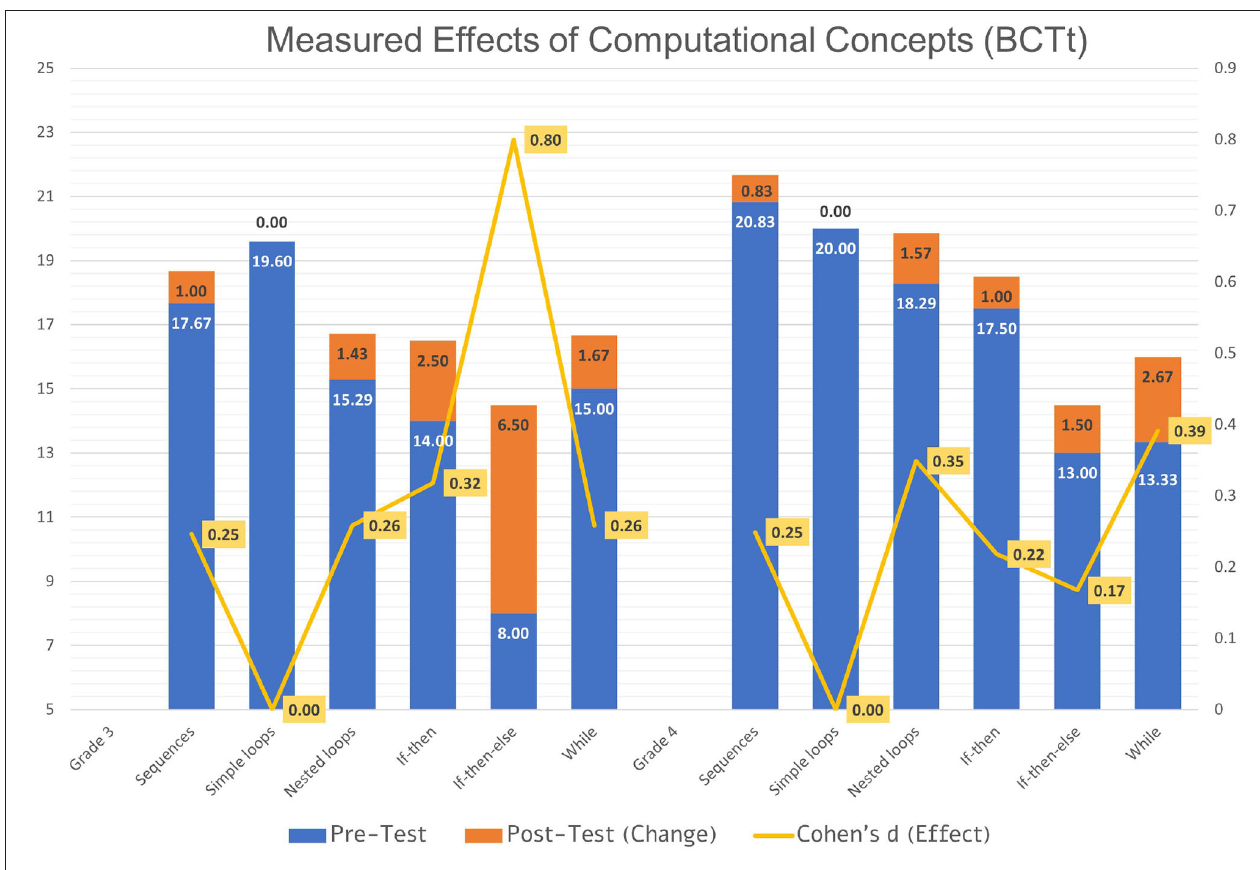
FIGURE 1 | BCTt results—computational concepts